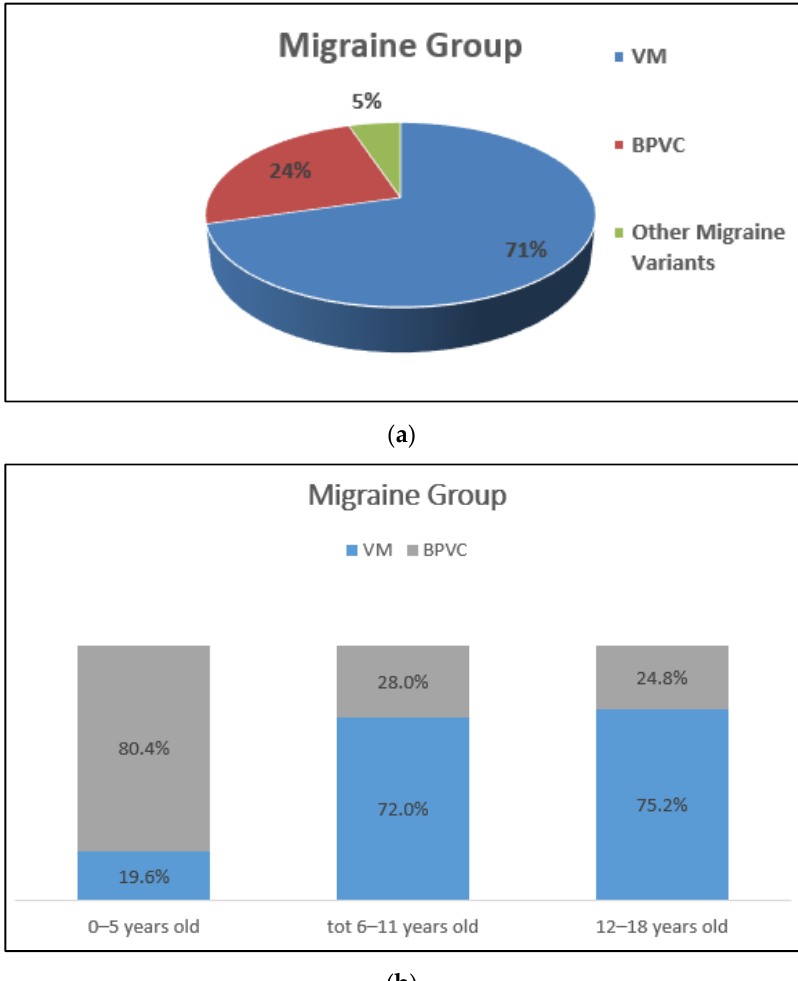
Figure 4. ( a ) Overall (percentage %) distribution of Migraines. VM: vestibular migraine; BPVC: benign paroxysmal vertigo of childhood. ( b ) Distribution of VM and BPVC according to age.